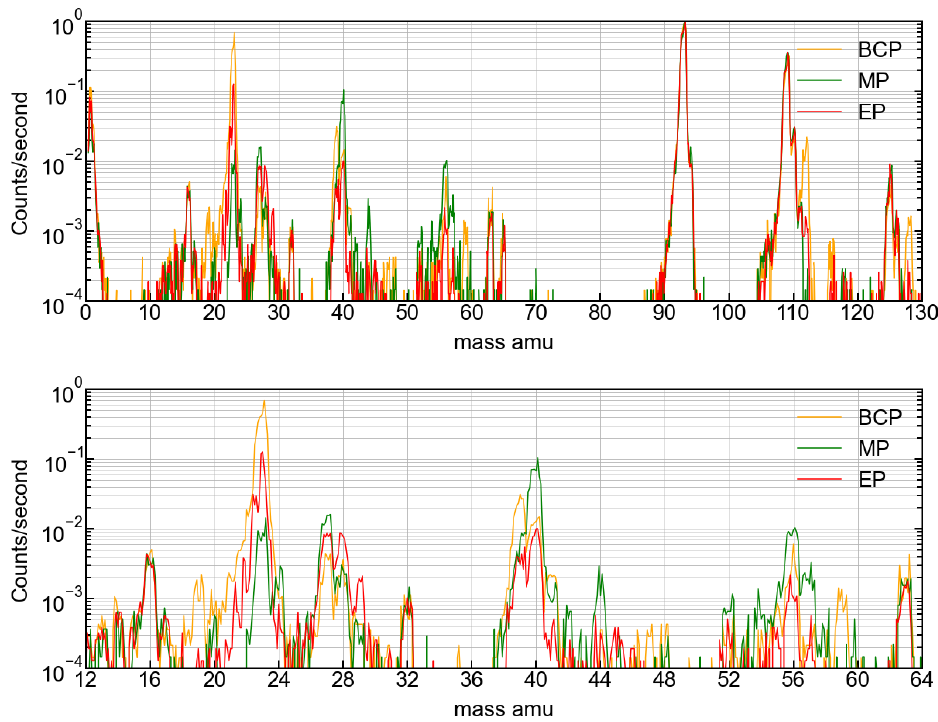
Figure 15. Mass spectrum for three types of samples MP (green), BCP (orange), and EP (red). Note: The upper image depicts the entire spectrum in the range of 0–200 amu, whereas the bottom image shows a zoomed-in view of the same spectrum, specifically in the range of 12–64 amu. AMU refers to atomic mass units. Table 1. Main observed Ions and Fragment Species in SIMS spectra recorded on Niobium after different surface processing (MP, BCP, EP).